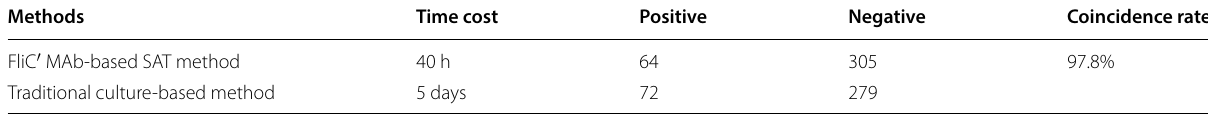
Table 3 Detection ability of FliC ′ MAb-based SAT method compared with traditional culture-based method Methods FliC ′ MAb-based SAT